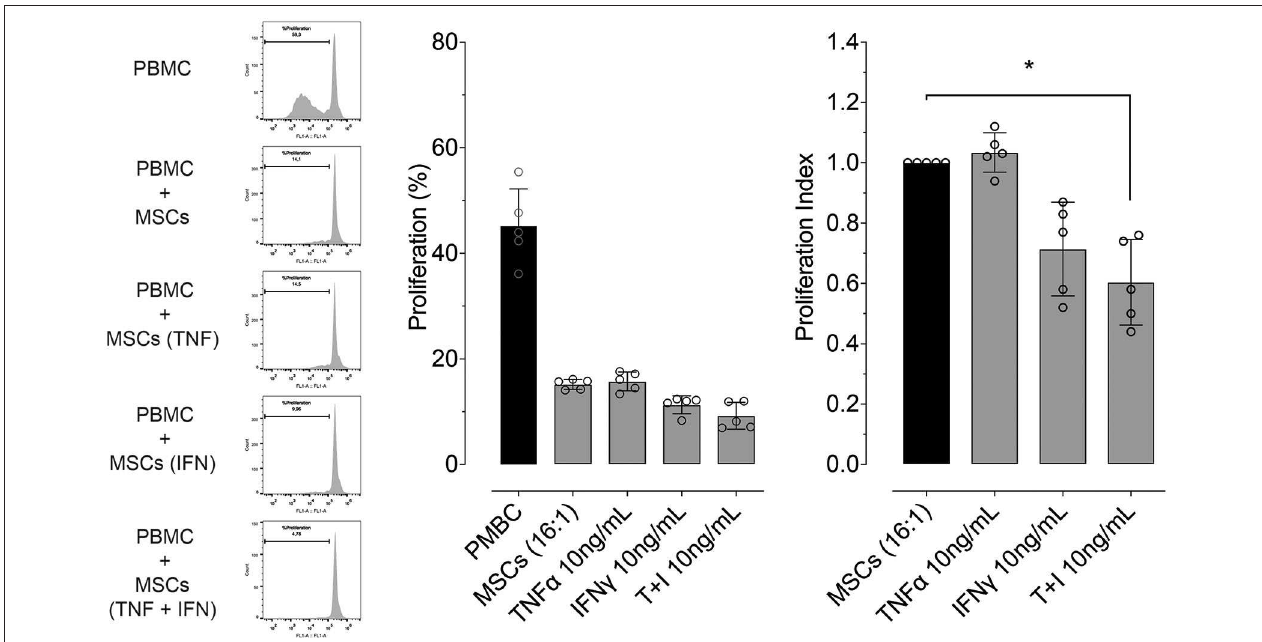
FIGURE 6 | Pre-conditioning increases the inhibitory effect of MSCs on lymphocyte proliferation. Left: representative flow cytometry images showing the inhibitory effect on lymphocyte proliferation, of a co-culture between peripheral blood mononuclear cells (PBMC) and MSCs in different conditions (naïve or preconditioned with TNF- α , IFN- γ or their combination). Proliferation was induced by incubation with 5 µ g/mL of concanavalin A (ConA) and determined by CFSE dilution. Right: inhibitory effect on lymphocyte proliferation of a co-culture between PBMC and MSCs in different conditions (naïve or preconditioned with TNF- α , IFN- γ or their combination) (* p < 0.05; n =